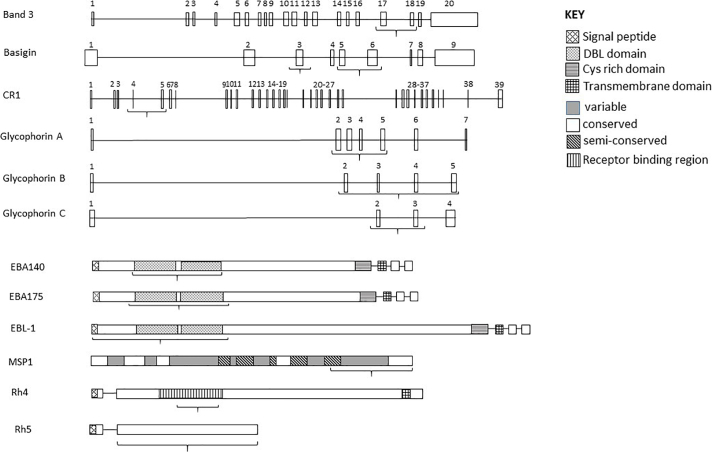
Scheme of the six erythrocyte receptor and merozoite ligand genes. The curly brackets indicate the regions of the genes identified as being involved in the receptor-ligand interaction that were sequenced. The scheme indicates the positions of the exons and the lengths are relative to differentiate the bigger from the smaller genes. These regions were amplified and sequenced to determine whether they were under selection.